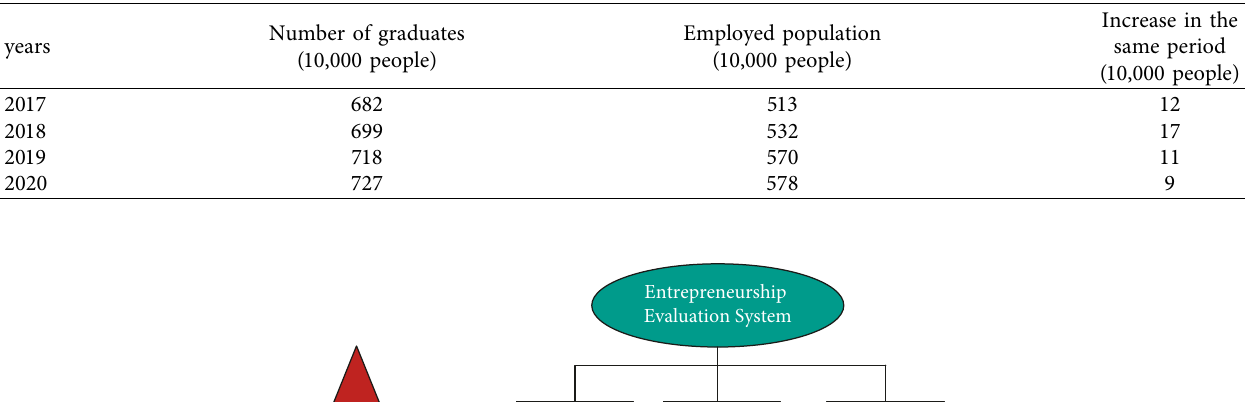
Table 2: The number of college graduates and employed persons from 2017 to 2020.